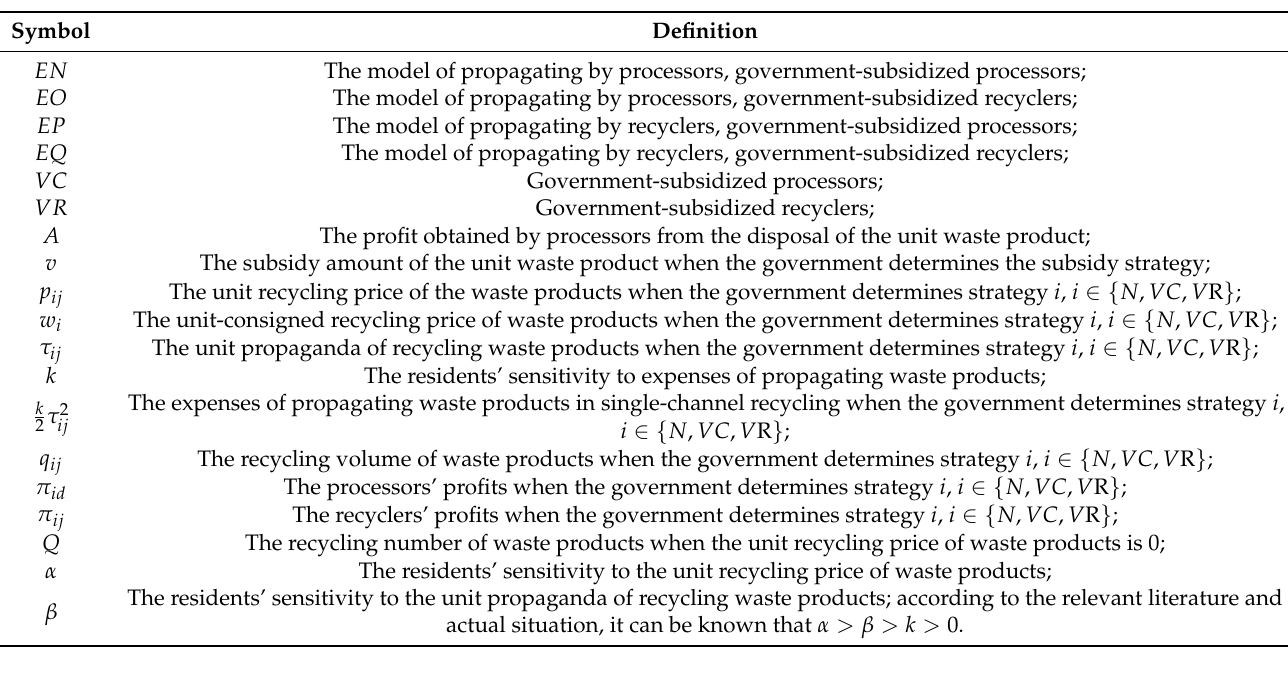
Table 1. Notation